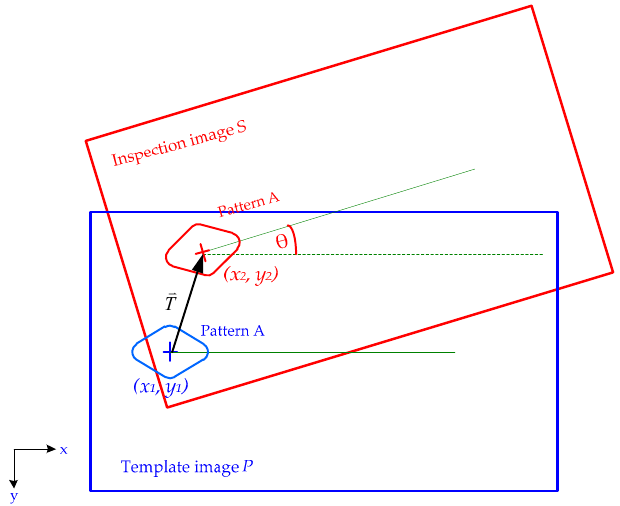
Figure 1. The geometric relationship between pattern image P and inspection image S .